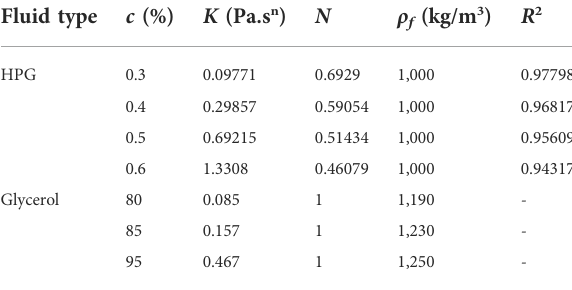
TABLE 1 Rheological properties of the fl